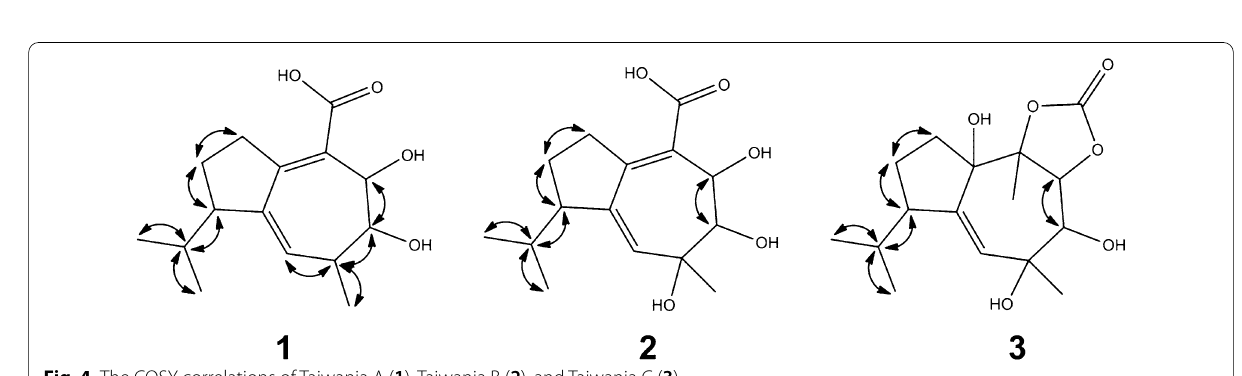
Fig. 4 The COSY correlations of Taiwania A ( 1 ), Taiwania B ( 2 ), and Taiwania C ( 3